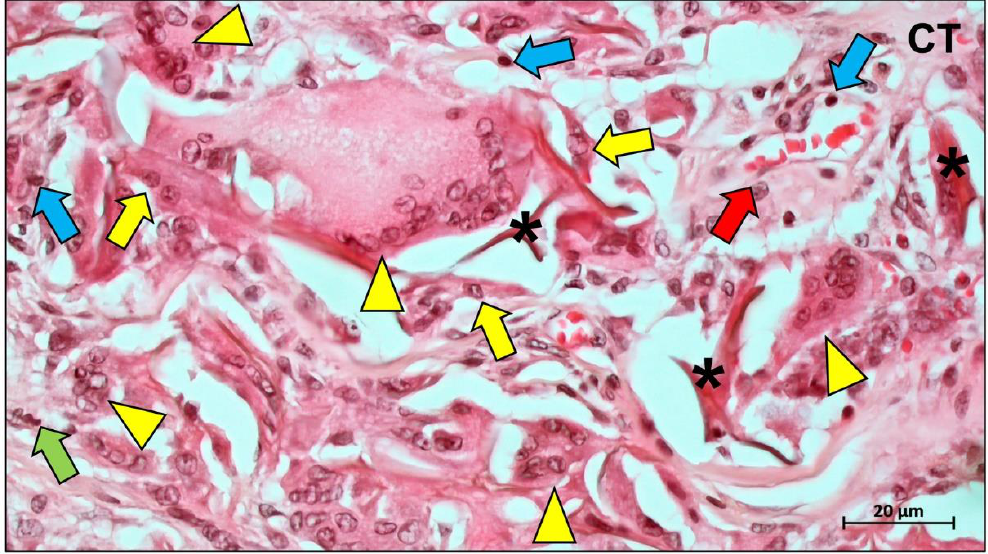
Figure 9. Representative histological image showing the strong inflammatory tissue reaction to a GA crosslinked collagen material (asterisks = material remnants) within the subcutaneous connective tissue (CT) at 15 days post implantationem. Yellow arrows = macrophages, yellow arrowheads = multinucleated giant cells, blue arrows = lymphocytes, green arrow = eosinophilic granulocyte, red arrow = blood vessel, (HE staining, 400× magnification, scalebar = 20 µm).